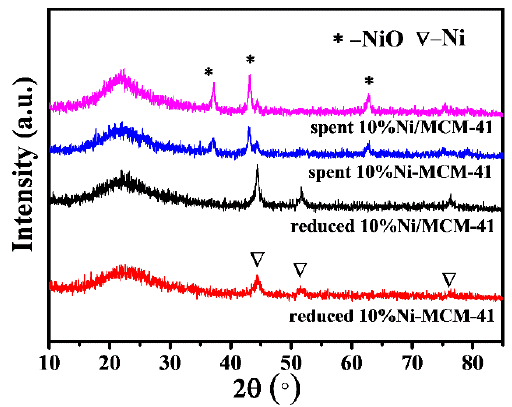
Figure 9. Wide angle XRD patterns comparation of reduced and spent 10%Ni/MCM-41 and 10%Ni-MCM-41 catalysts.